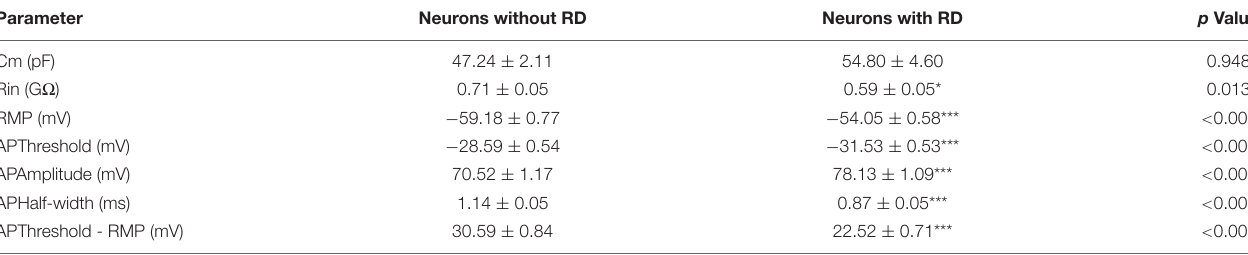
TABLE 1 | Comparison of intrinsic membrane properties of SG neurons with or without RD. Parameter Neurons without RD Neurons with